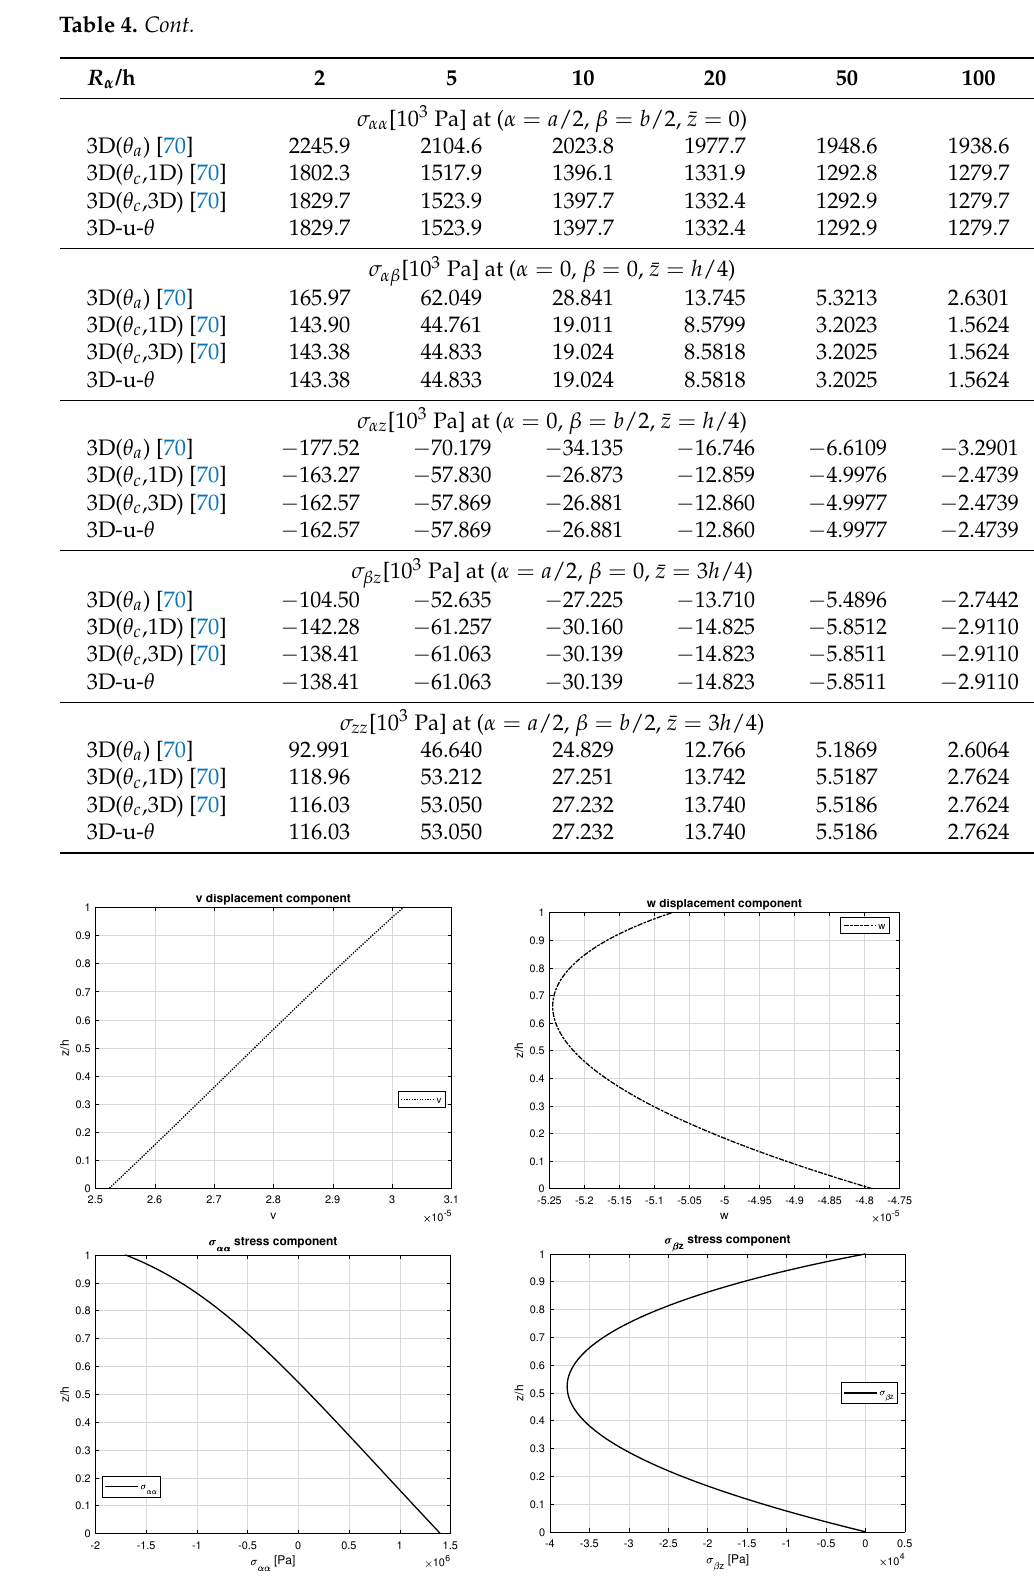
Figure 7. Second benchmark, displacements and stresses for a thick ( R α / h = 10) simply supported cylinder with one FGM ( p = 1) layer obtained using the 3D-u- θ model. Maximum amplitudes: w and σ αα at ( a /2, b /2); v and σ β z at ( a